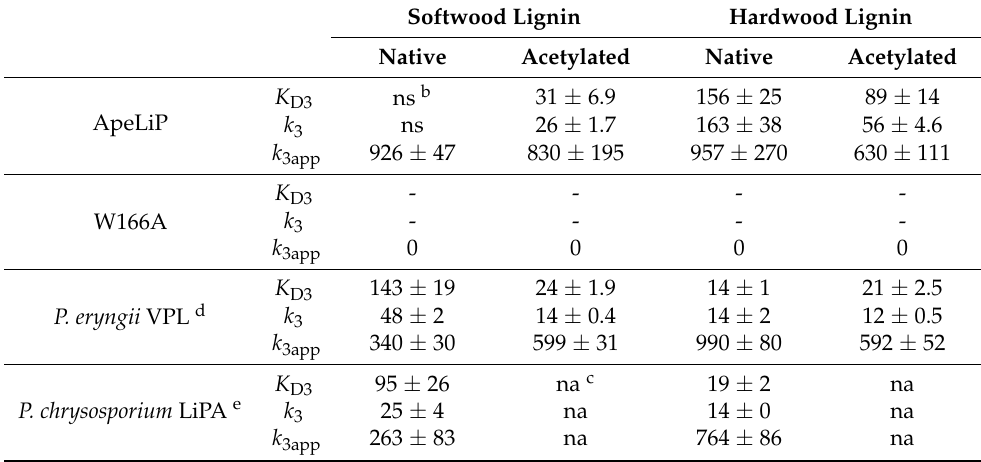
Table 3. Transient-state kinetic parameters— K D3 ( µ M), k 3 (s − 1 ), and k 3app (s − 1 · mM − 1 ) —for rate- limiting reduction of CII of ApeLiP, its W166A variant, P. eryngii VPL, and P. chrysosporium LiPA (isoenzyme H8) by native and acetylated softwood and hardwood lignosulfonates a . Softwood Lignin Hardwood Lignin Native Acetylated Native Acetylated K D3 ns b 31 ± ApeLiP